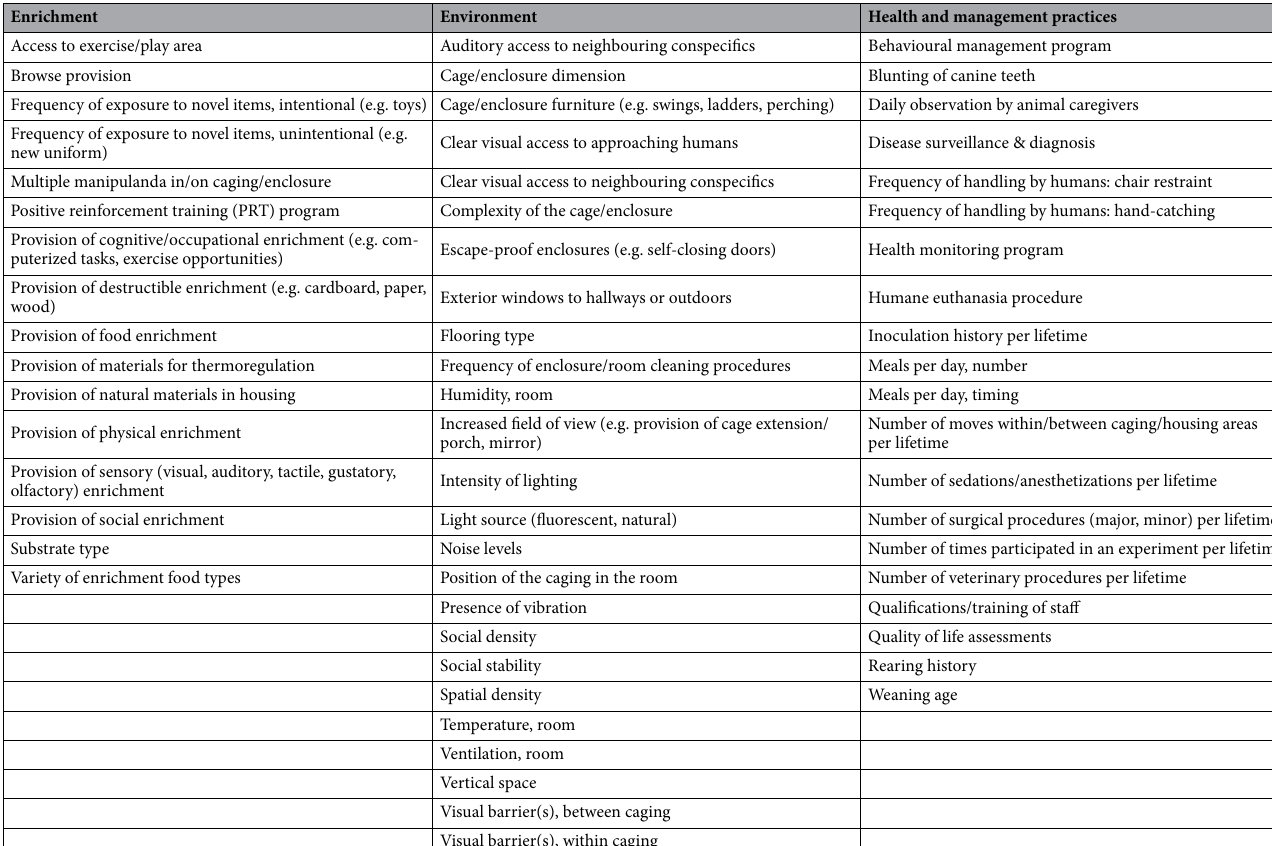
Table 7. Initial list of potential environment-based